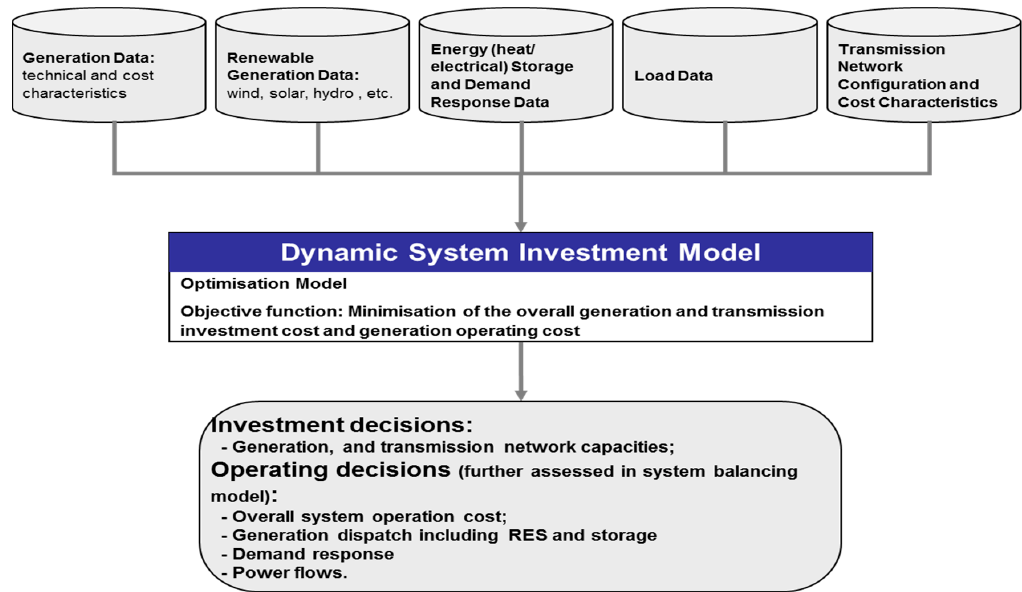
Figure 2. Structure of the Whole-electricity System Investment Model (WeSIM).